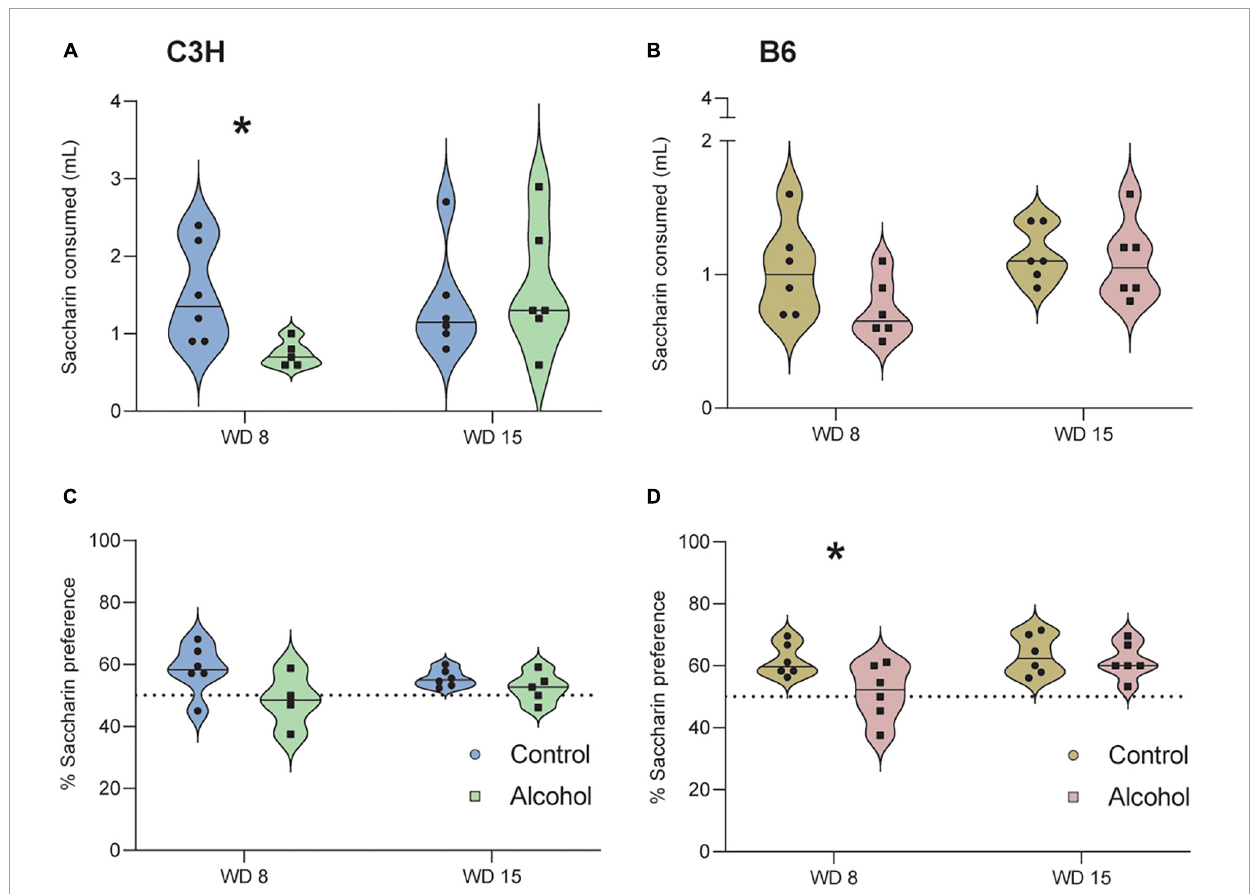
FIGURE6 Anhedonia-like effects following alcohol exposure and subsequent withdrawal in the saccharin preference test. The saccharin intake (A,B) and the % of saccharin preference (C,D) were assessed in C3H and B6 mice at the 8th and 15th day of alcohol withdrawal. Data are shown as individual subjects with violin plots. Note the truncated ordinate in panel (B) . n = 4–6 per group/strain. * p < 0.05 represents unpaired t -test, alcohol vs. control.